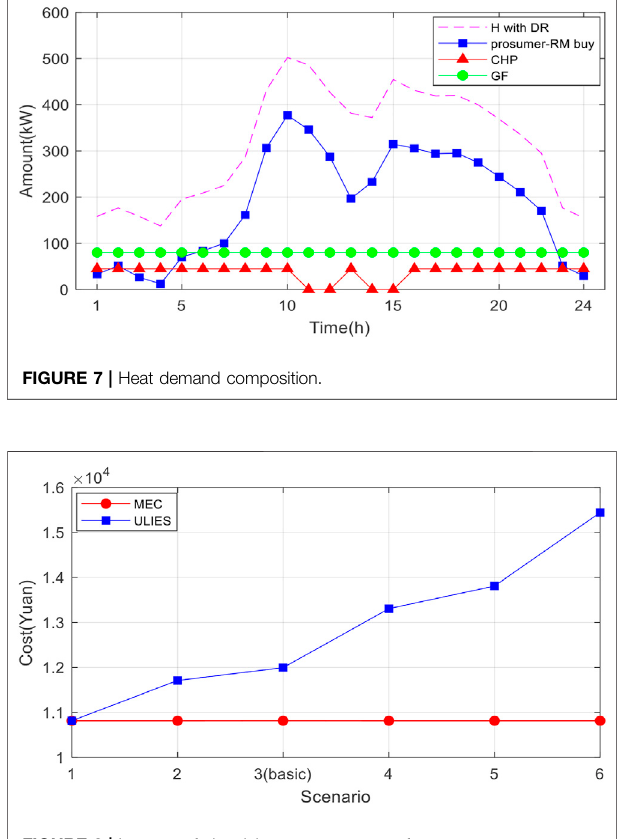
FIGURE 8 | Impacts of electricity usage patterns of prosumers.